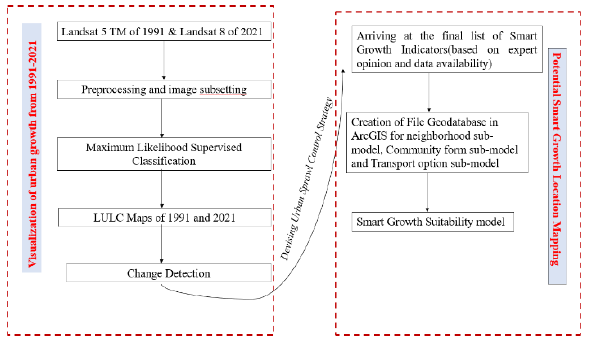
Figure 2 : Flow chart of the